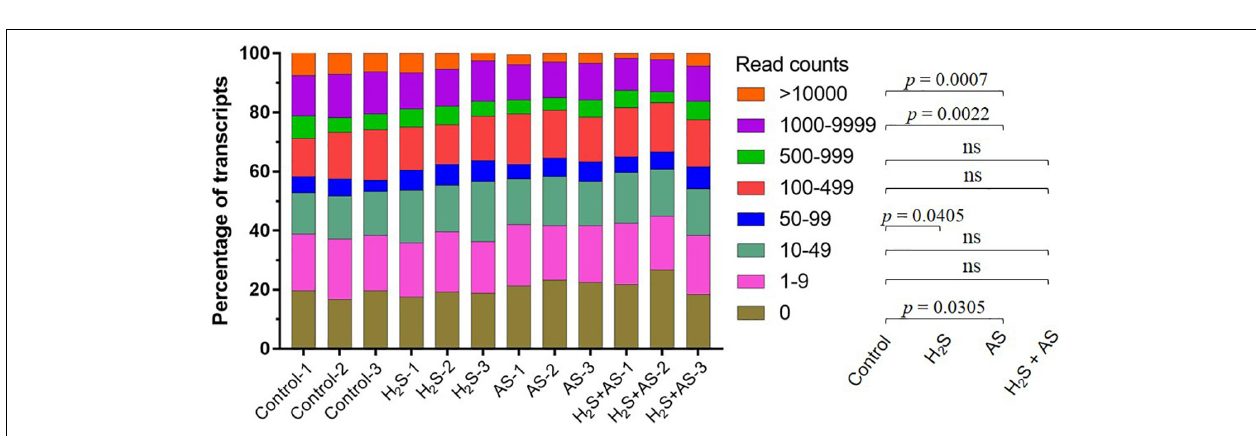
FIGURE 1 | Distribution of conserved miRNA family members in M. hupehensis roots. 76 of 115 identified known miRNAs belong to 37 families.